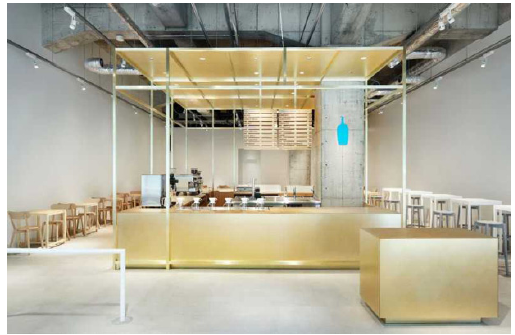
Figure 27. Blue Bottle in Kobe [78].